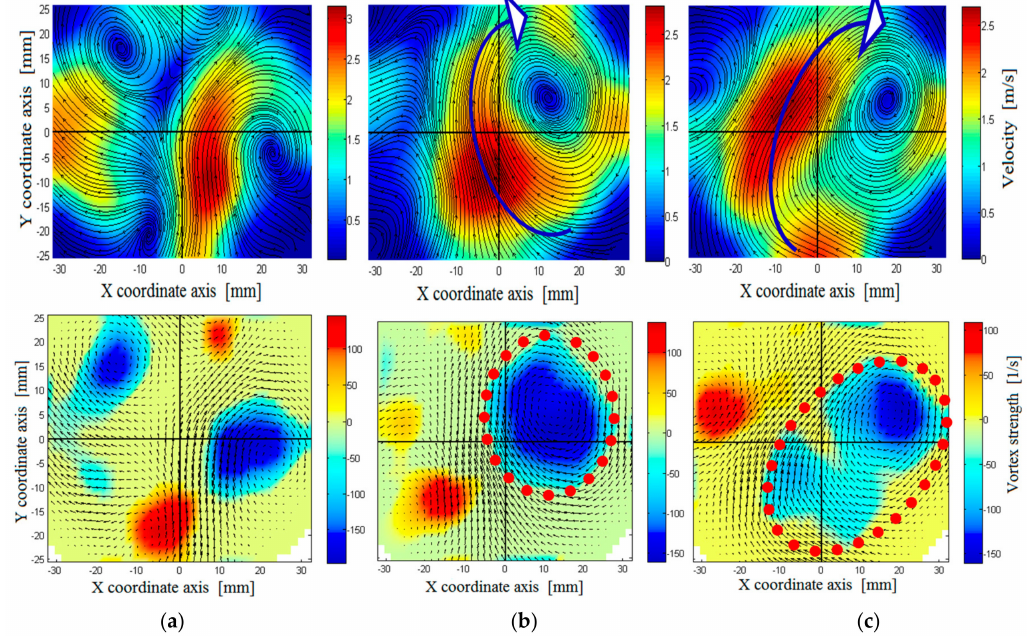
Figure 10. Streamlines and local swirl strength maps on the swirl plane half-way in the cylinder for ( a ) case 1; ( b ) case 2; and ( c ) case